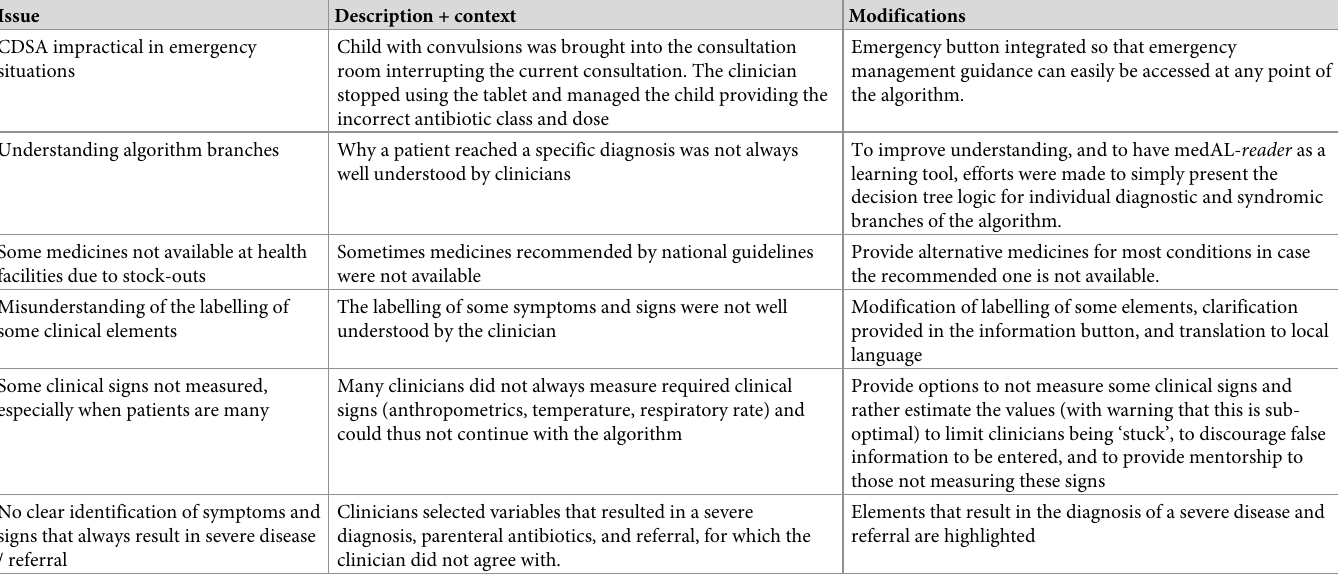
Table 1. Example of modifications based on user-experience feedback and